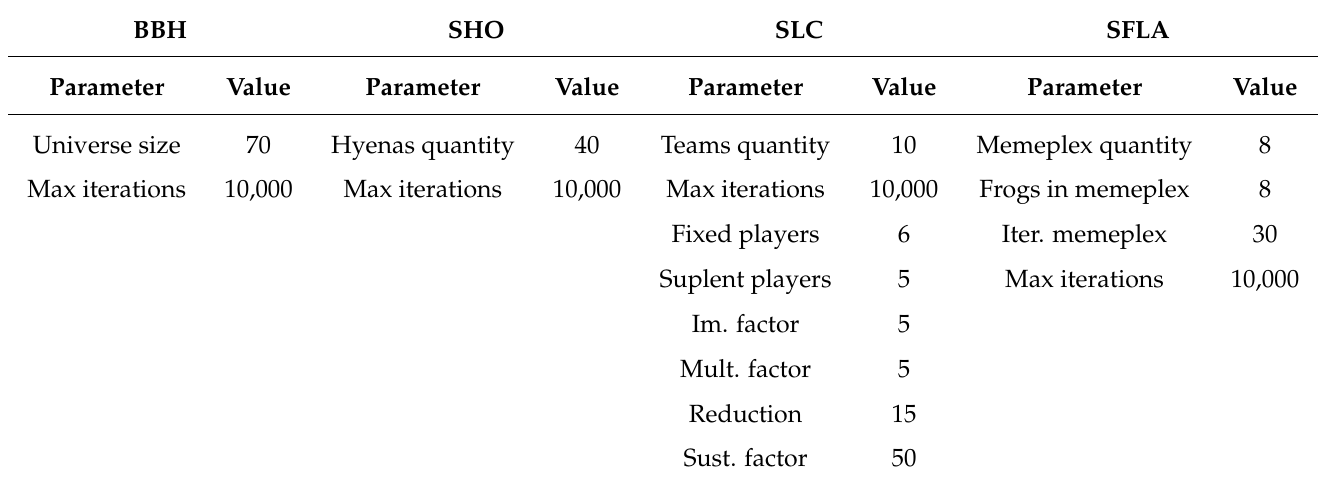
Table 1. Algorithms main